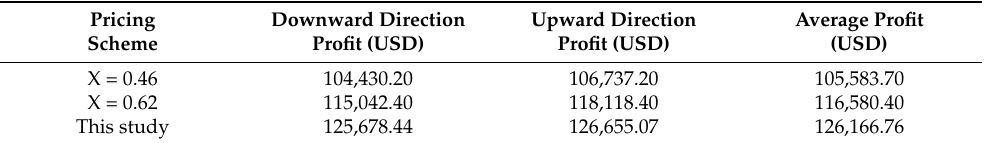
Table 4. Comparison of high-speed railway express profit.